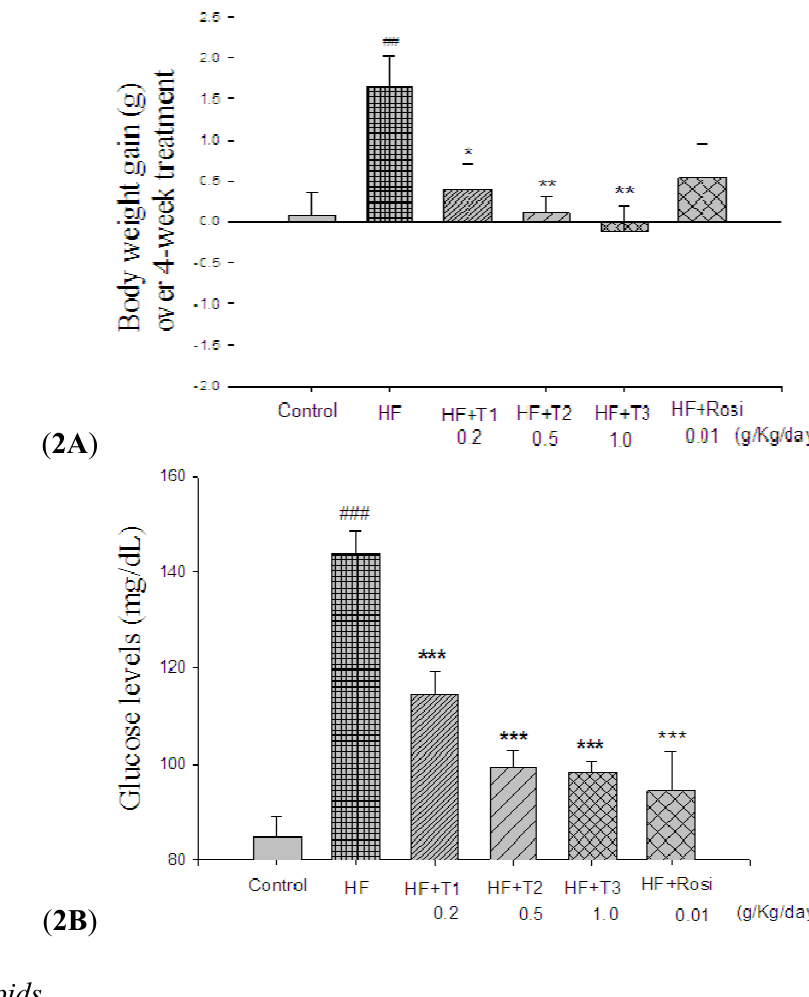
Figure 2. Effect of cell suspension culture of Eriobotrya japonica (TA) on ( A ) Body weight gain over 4-week treatment and ( B ) blood glucose levels at week 12. Blood samples were collected from the retro-orbital sinus of fasting mice and the level of glucose was measured by the glucose oxidase method. Mice were fed with 45% high-fat diet (HF) or low-fat diet (CON) for 12 weeks. After 8 weeks, the HF mice were treated with vehicle (water; p.o.), or TA, or rosiglitazone (p.o.) accompanied with HF diet for 4 weeks. All values are means  S.E. (n=9). ## p < 0.01, ### p < 0.001 compared with the control (CON) group; * p < 0.05, ** p < 0.01, *** p < 0.001 compared with the high-fat + vehicle (distilled water) (HF) group by ANOVA. T1, T2 and T3: cell suspension culture of Eriobotrya